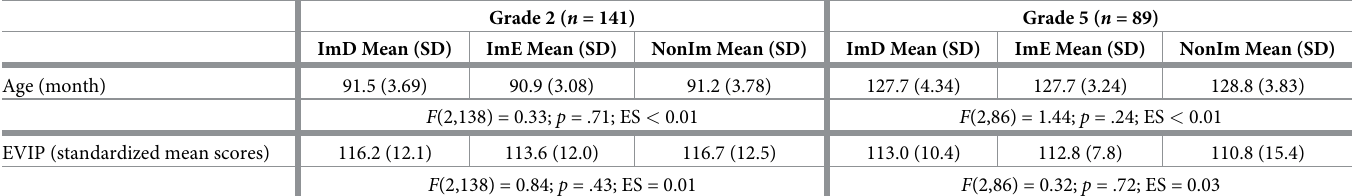
Table 2. Sample characteristics (age), descriptive statistics, and t-tests of comparison in age and verbal intelligence